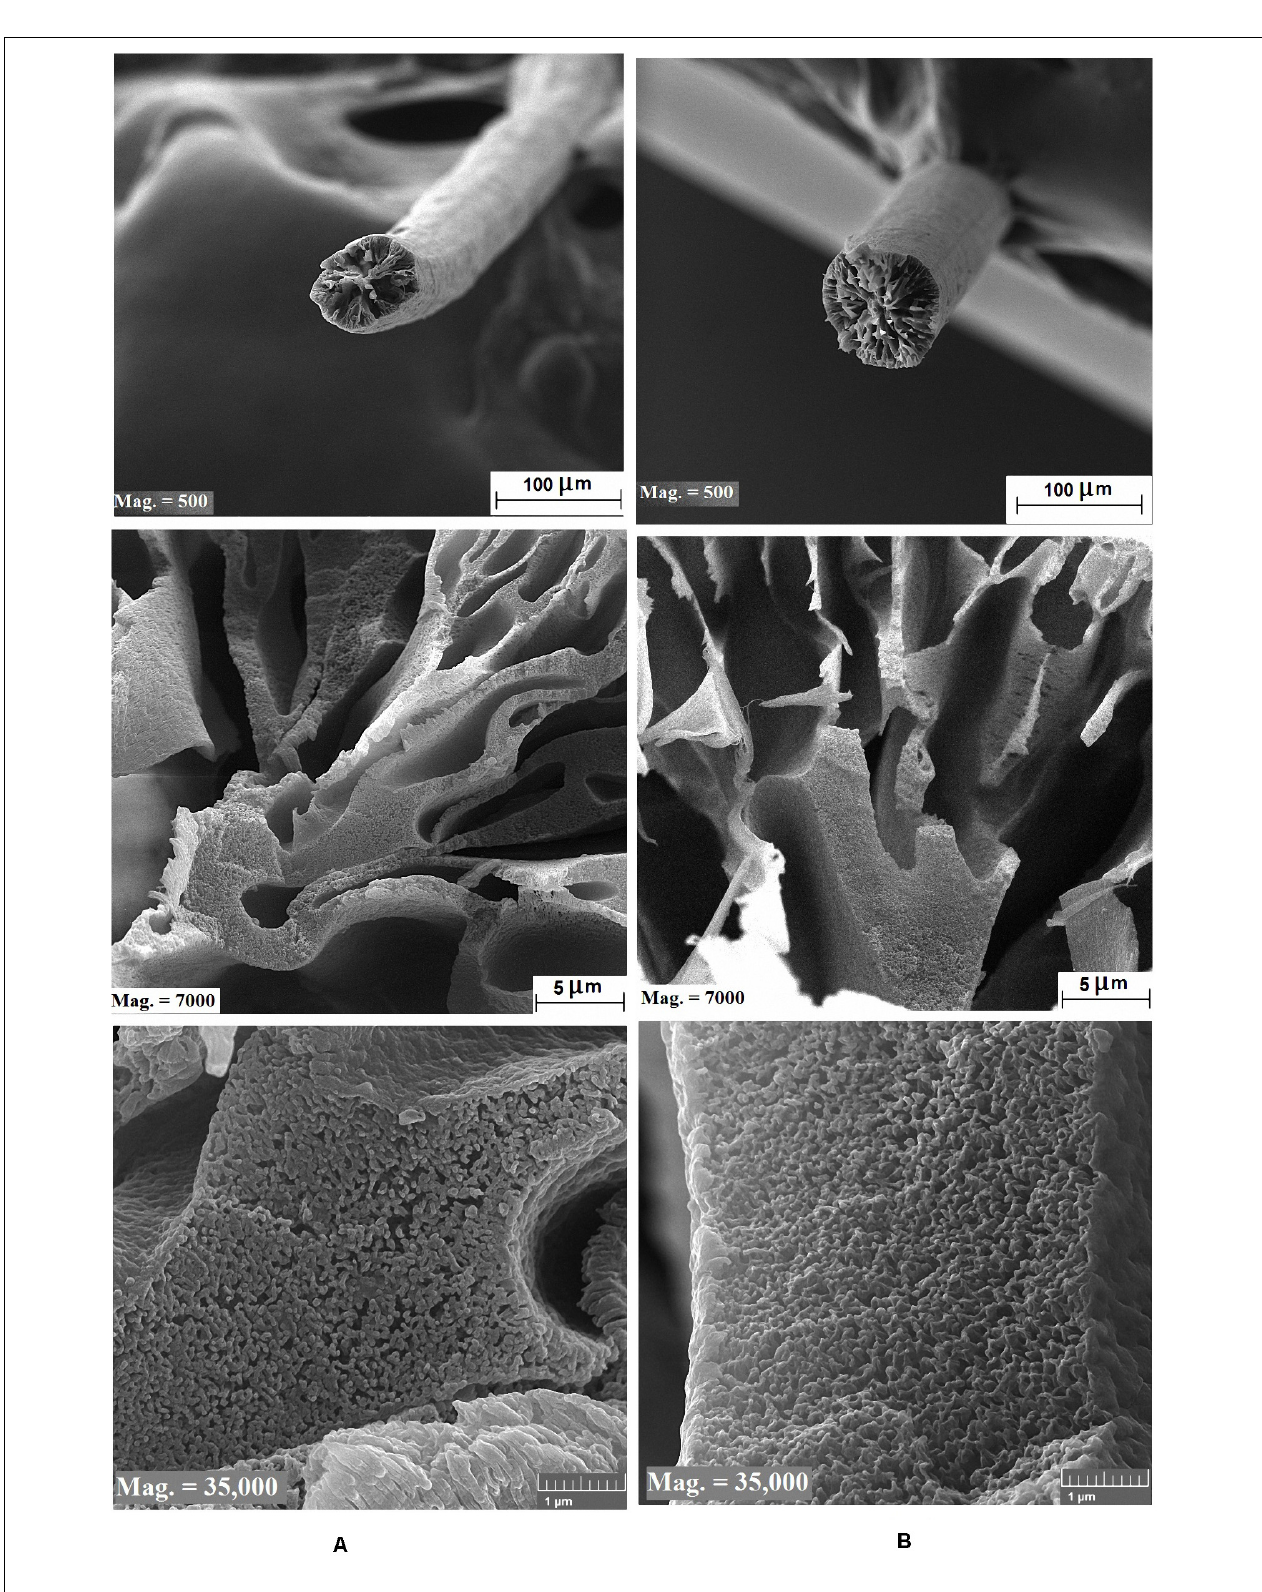
FIGURE 4 | FESEM images of the cross section and morphology of PAN/CNT and PAN fibers at magnifications of 500 × , 7,000 × , and 35,000 × . (A) PC-S2-D5, and (B) P-S2-D5.